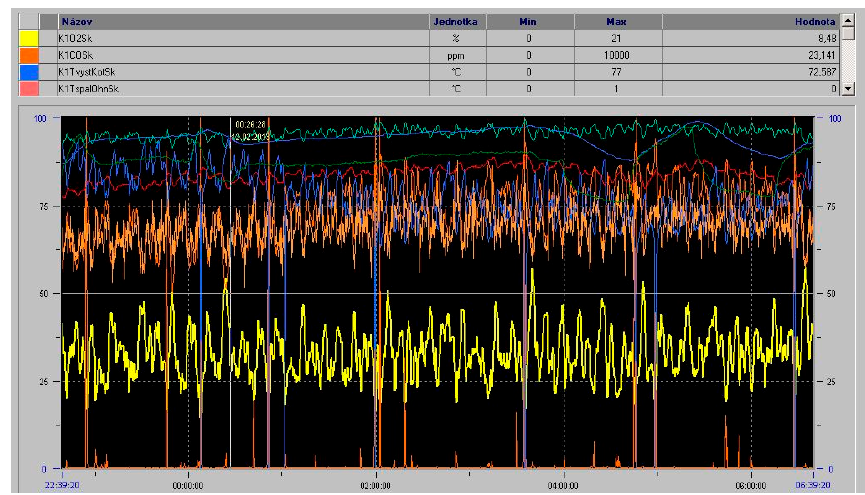
Figure 13. Remote monitoring of biomass combustion process variables.